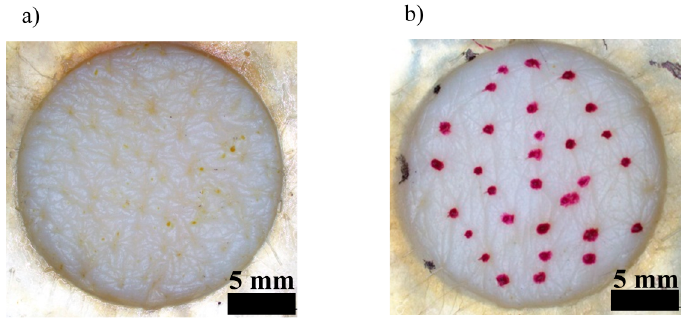
Figure 1. Pictures of the skin surface with ( a ) or without ( b ) hair follicle